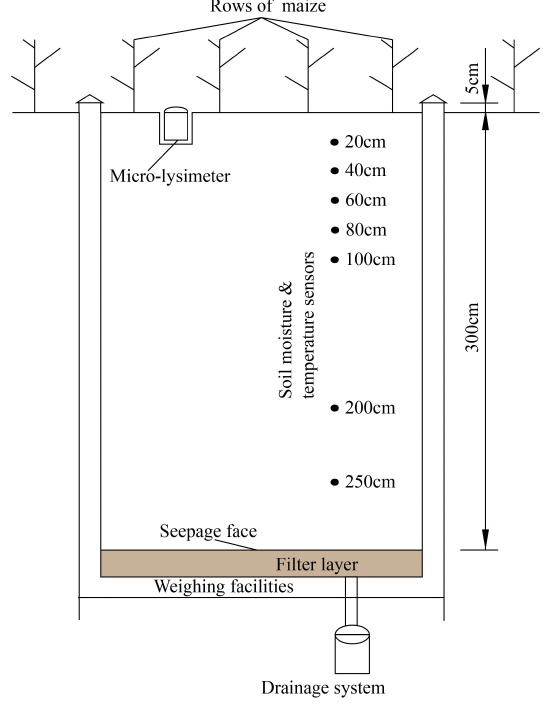
Figure 1. Schematic drawing of the large lysimeter structure.